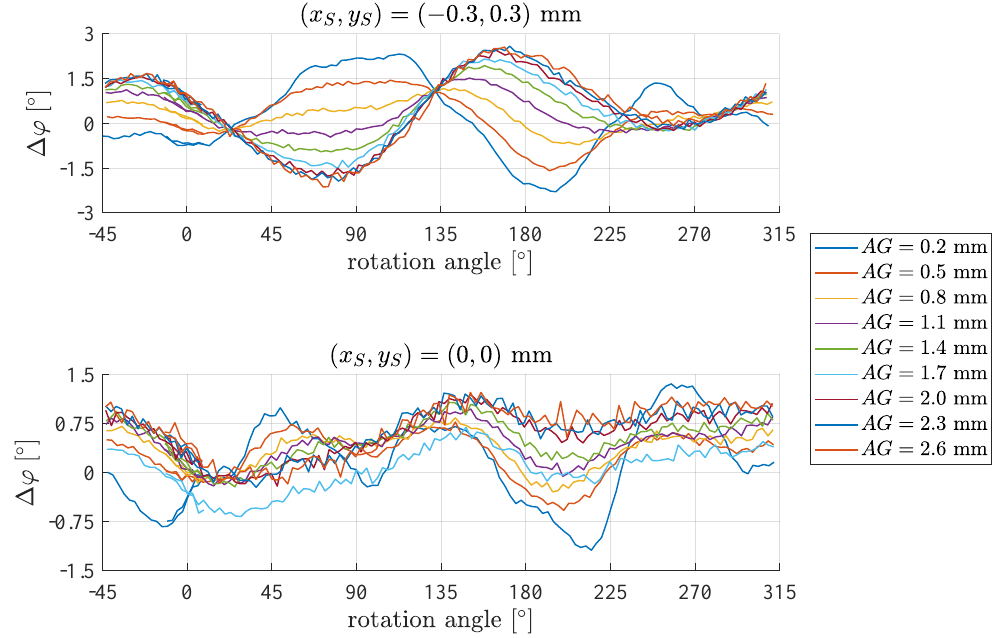
Figure 8. ∆ ϕ versus rotation angle for ( a ) ( x S , y S ) = ( − 0.3,0.3 ) mm and ( b ) ( x S , y S ) = ( 0,0 ) mm from Figure 7. Two different patterns are detectable: ˜ T axial dominates for small AG and ˜ E axial dominates for large AG . Tilts and magnet eccentricity are not quantified but small and equal for all